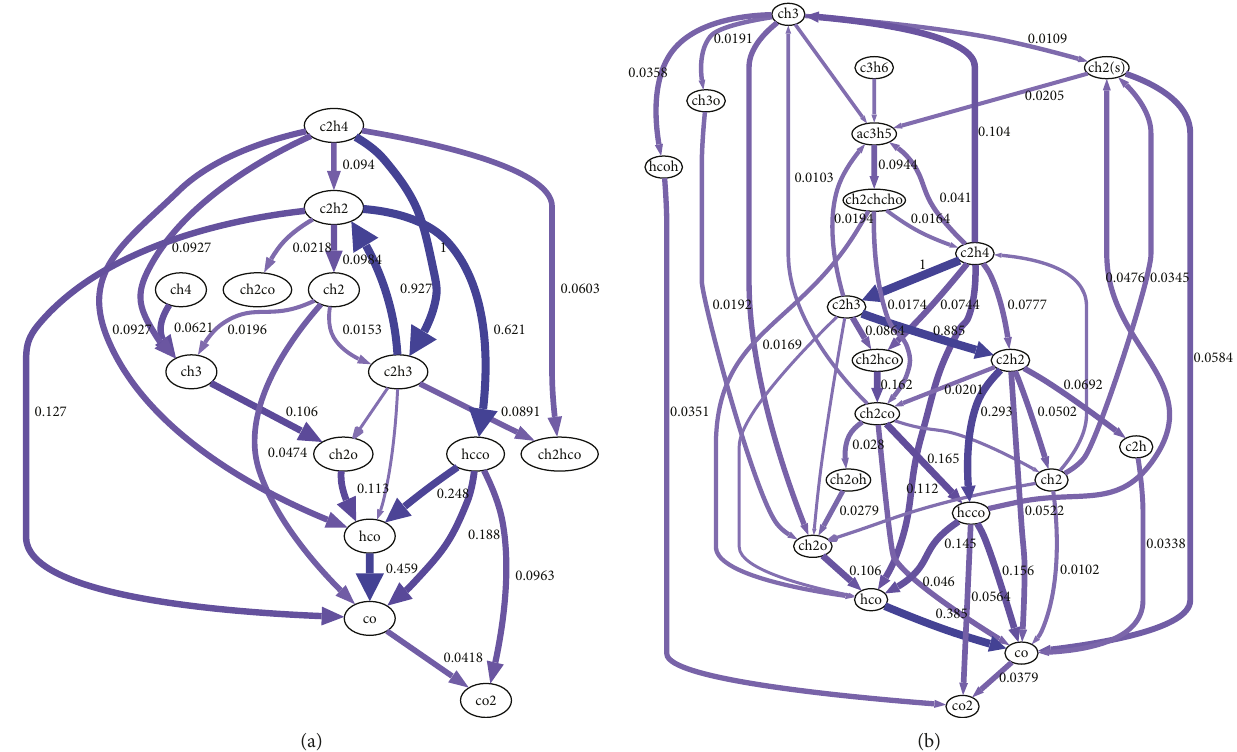
Figure 8: Analysis of reaction paths based on reaction mechanisms, (a) reduced mechanism and (b) detailed